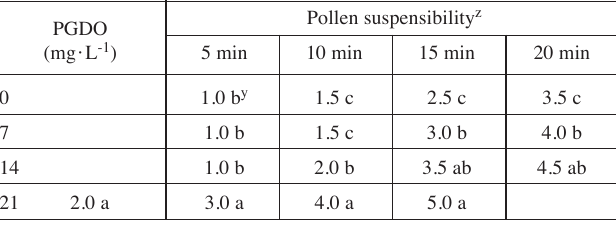
Tab. 2: Effect of PGDO concentrations in pollen liquid diluent on the suspensibility by sensory evaluation of ‘Matua’ kiwi pollen.